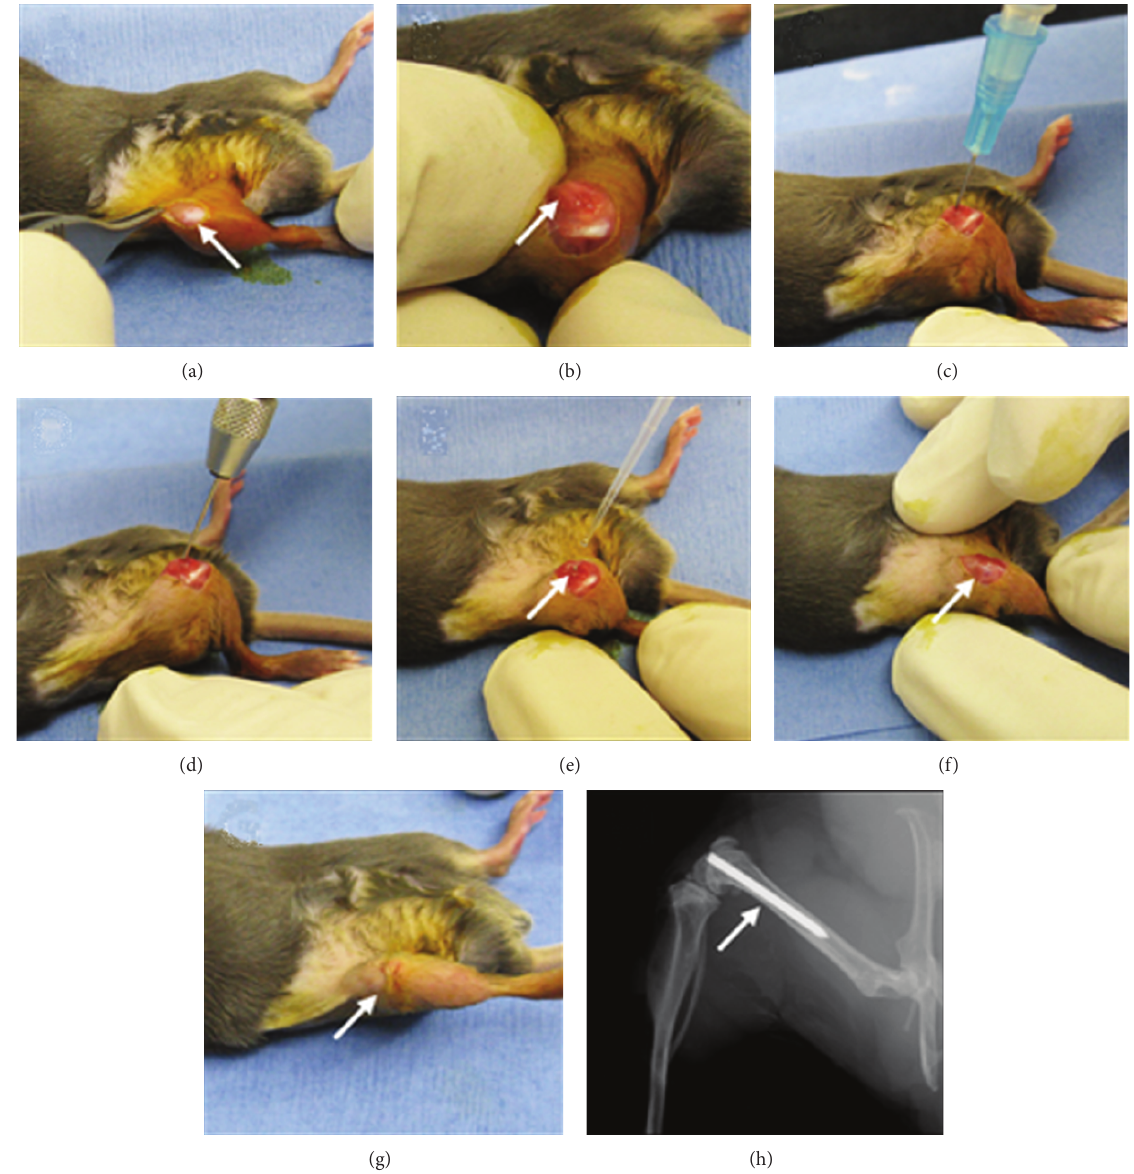
Figure 3: ((a)–(g)) Bernthal et al. surgical approach in a representative mouse. (h) A radiograph demonstrating placement of the implant in the femoral canal with the cut end extending into the knee joint